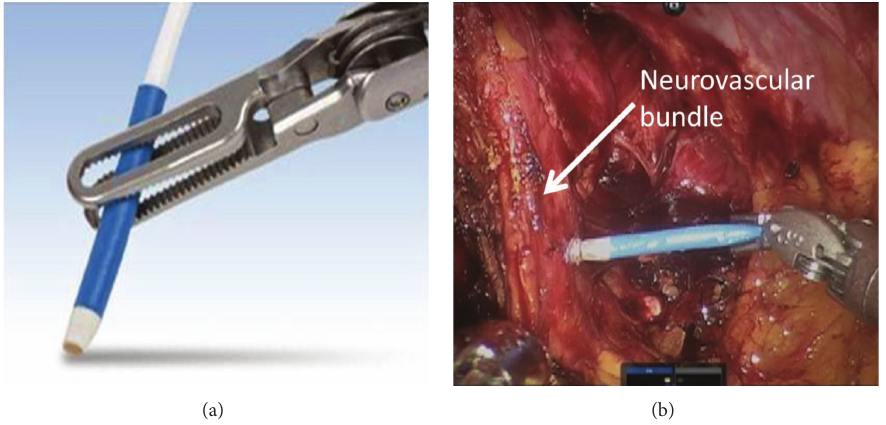
Figure 1: Demonstration of probe manipulation with robotic arm (a). Example of intraoperative manipulation (b).